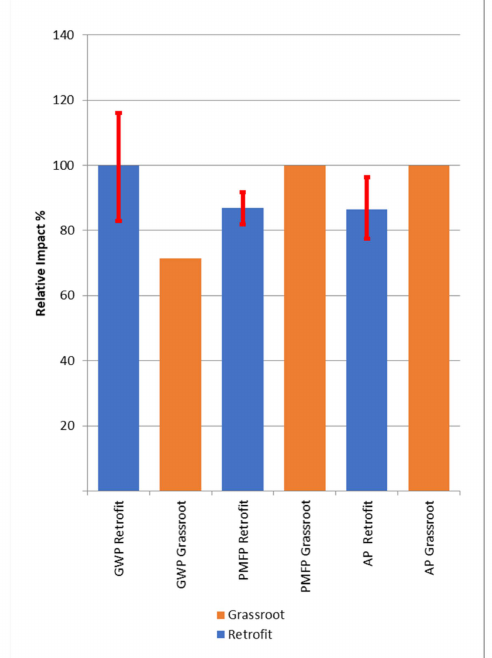
Figure 10. Relative impact analysis for both